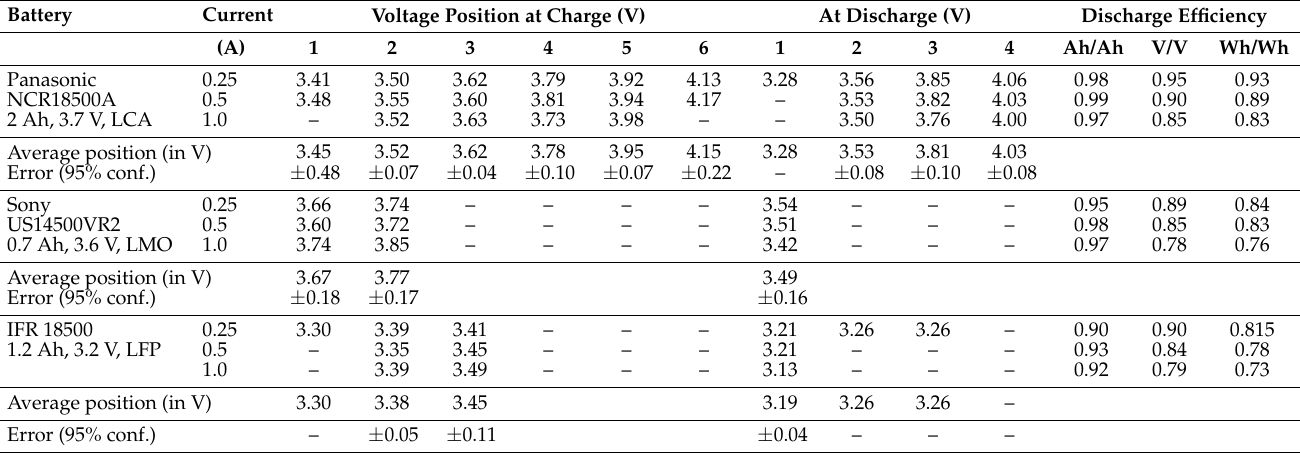
Table 2. Differential capacity peaks d Q /d U at three currents of different lithium-ion